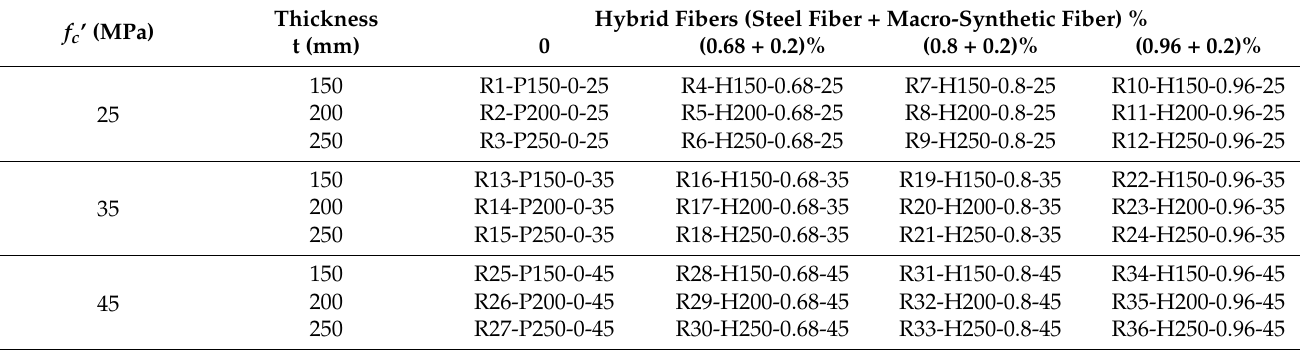
Figure 2. The schematization of a concrete slab on Winkler spring foundation [49]. The designation of rigid hybrid fiber concrete (RHFC) contains three terms. The first term represents the sample number (R No.), the second term represents the type of pavement: pavement control (P) or hybrid fiber (H) with a slab thickness of (150, 200, and 250), the third term represents the steel fiber ratio which is used in the mix of the sample. Table 1 shows the framework of this study with all specimens properties of FE analysis. Table 1. Properties of finite element of rigid hybrid fiber concrete RHFC.